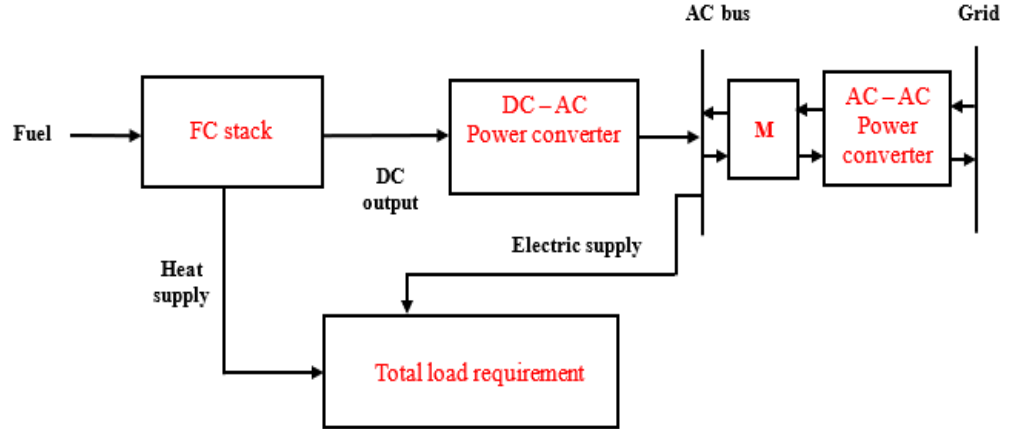
Figure 3. Grid-integrated application of FC power for residential loads.